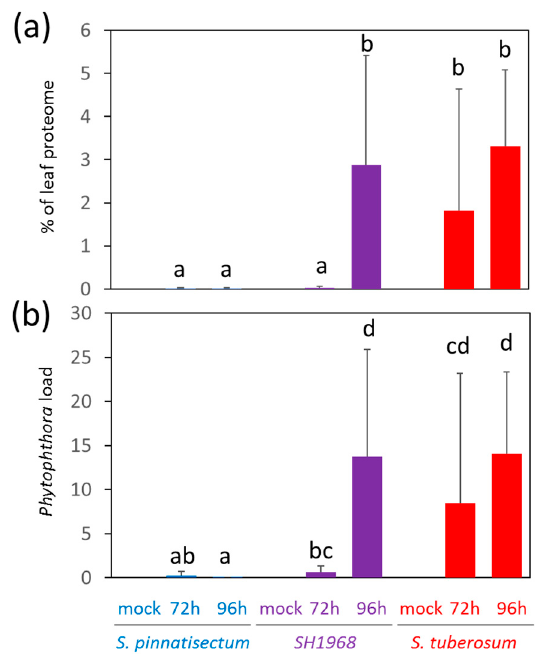
Figure 3. Estimated Phytophthora protein content in inoculated leaves ( a ) and relative Phytophthora load ( b ) based on the qPCR determination of PiO8 normalized to PGSC0003DMG400023270 . Results represent the mean and standard deviation (n = 5), and different letters indicate significant differences (Kruskal–Wallis, Conover test p < 0.05).